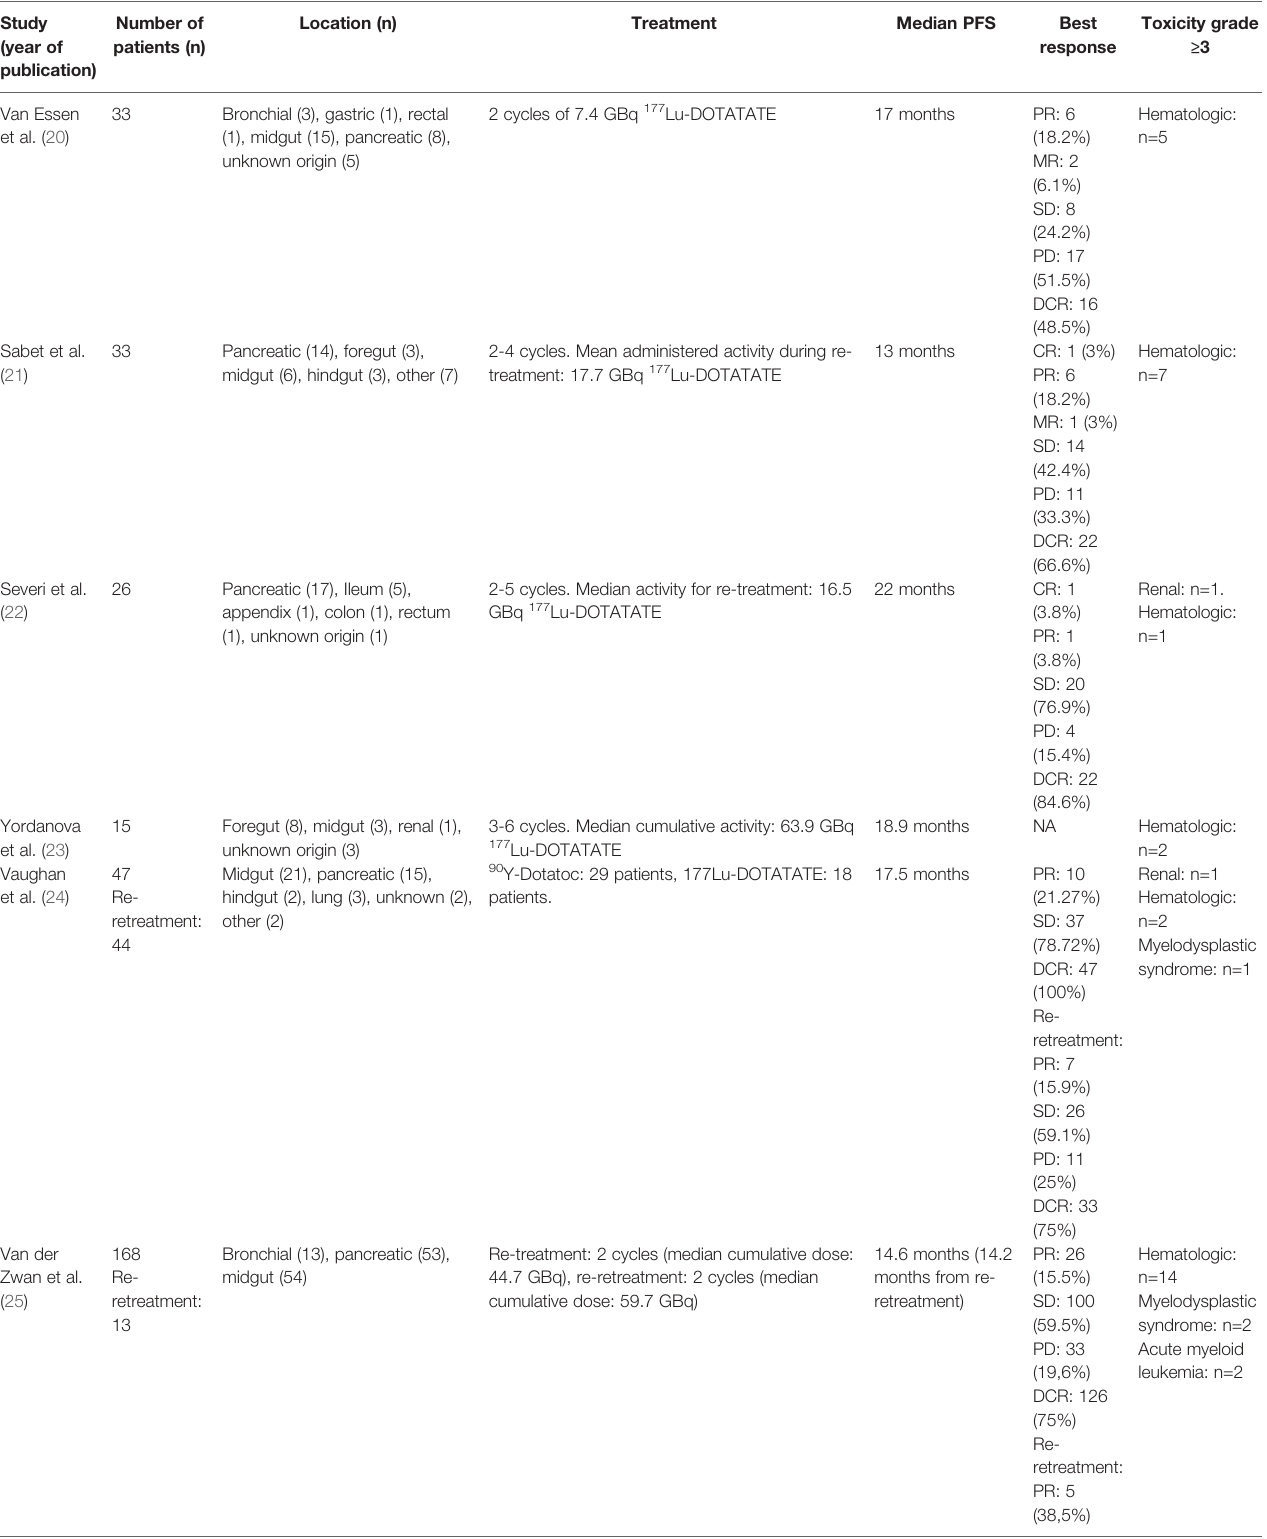
TABLE 1 | Published studies that evaluate salvage with